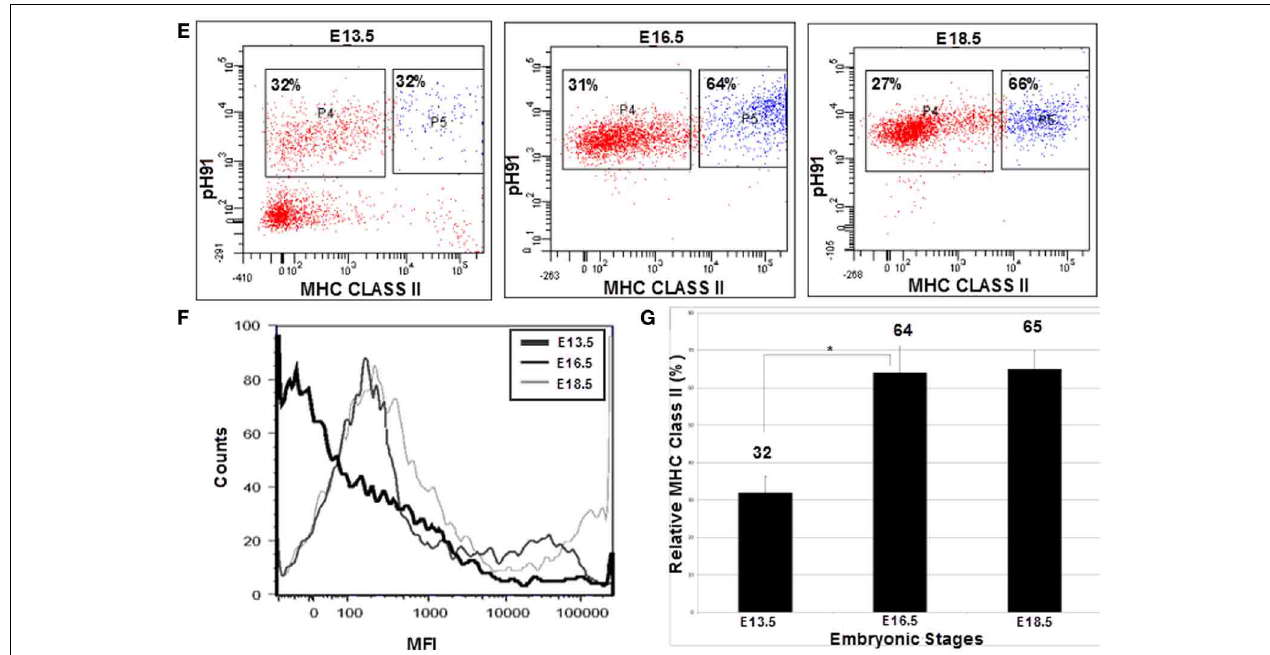
FIGURE 7 | Ontogeny expression of MHC Class II on the cell surfaces of multicellular TNCs. The development of TNCs was followed embryonically beginning at E13.5. TNCs were isolated from stages E13.5, E14.5, and E17.5. Isolated cells were cyto-spun onto glass slides and stained with pH91 antibody (green) and DAPI (blue), pH91 + cells were seen at different stages of cell cycle. (A) shows bi-nucleated cells (arrows). (B) shows TNCs expressing fibrous extensions (arrow). (C) shows pH91 + cells undergoing division. (D) shows a small TNC complex isolated from an E17.5 embryo. The TNC is seen with internalized